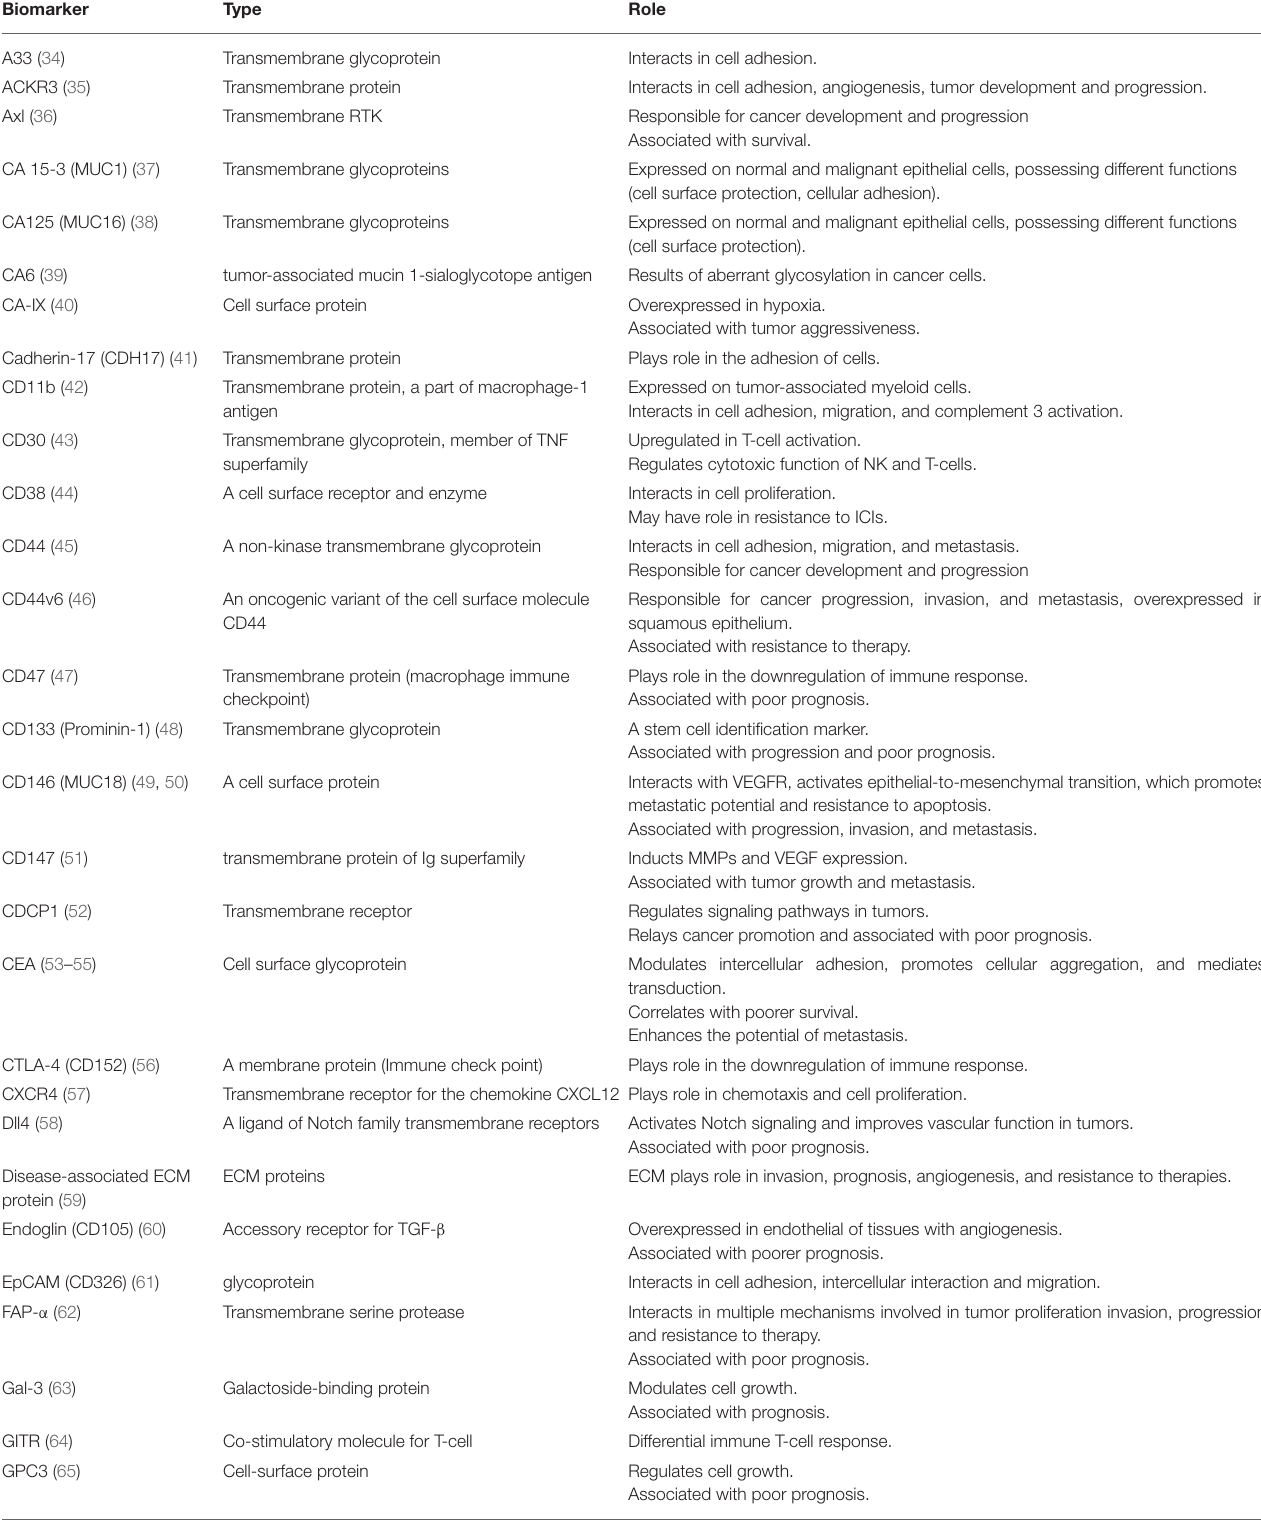
TABLE 1 | Biomarkers targeted in different malignancies for immunoPET imaging.